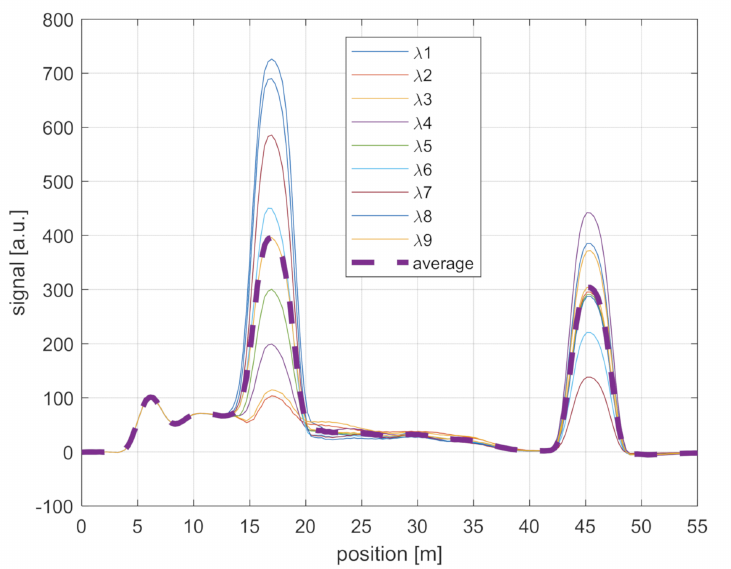
Figure 2. The φ -OTDR traces acquired over the GI-POF. The solid lines are the traces acquired for each laser wavelength, while the dashed line corresponds to their